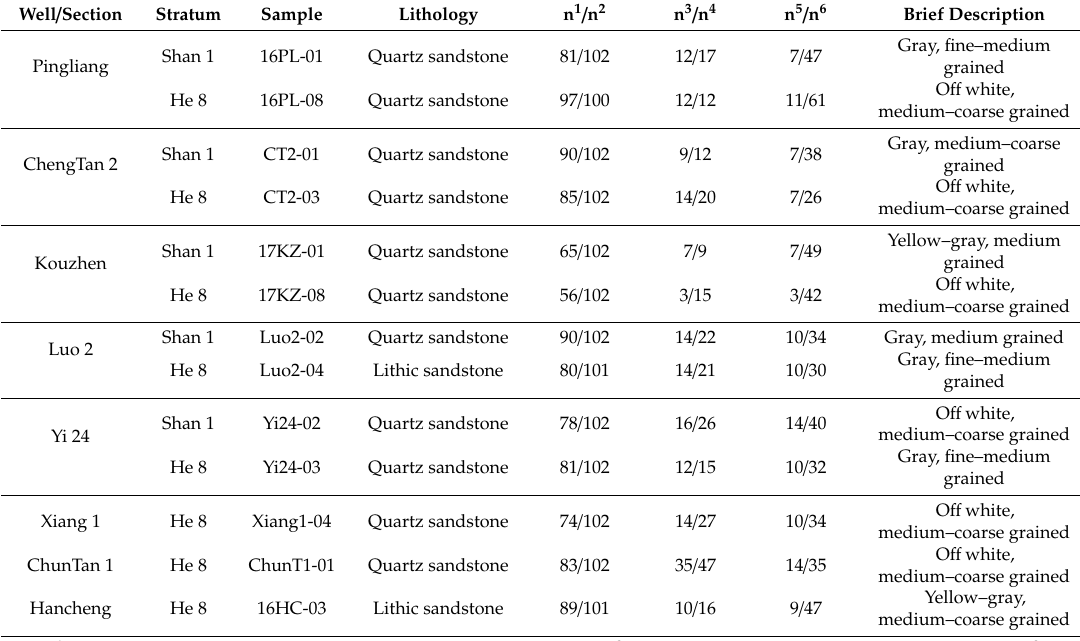
Figure 3. Microphotos of the sandstone samples from the SOB. All are shown under cross–polarized light. Q: quartz, Pl: plagioclase, Bi: biotite, LF: lithic fragment, QO: quartz overgrowth. Table 1. Summarized samples